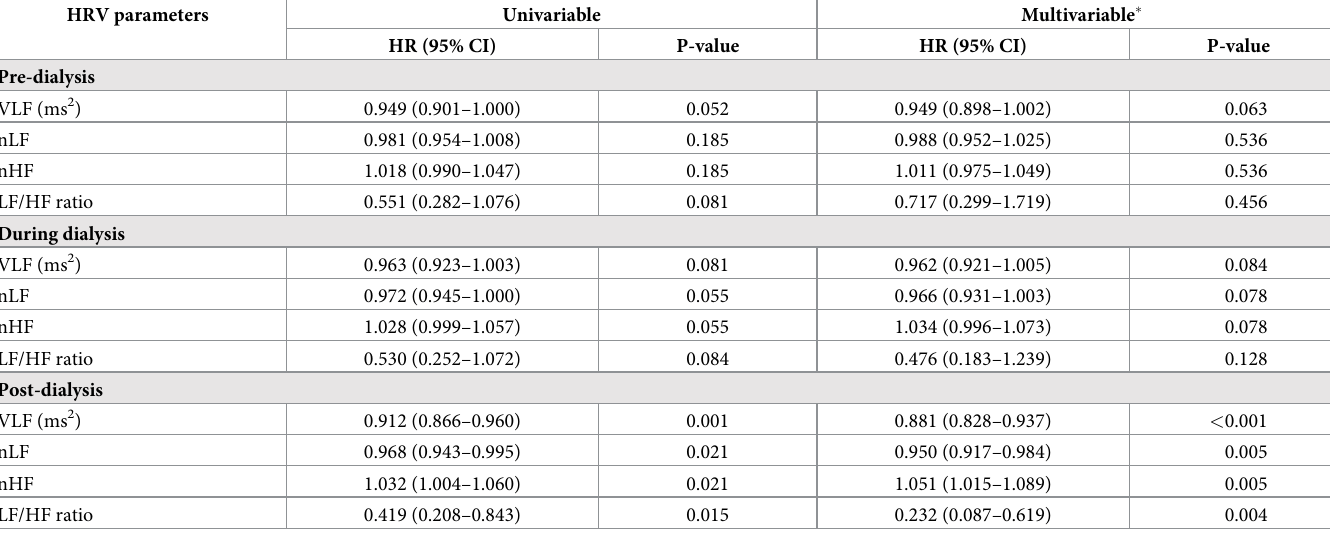
� Adjusted for age, LVEF, albumin, hemoglobin, coronary artery disease, use of beta-blockers, use of ACEI/ARB, use of oral anticoagulation, and pre-dialysis DBP. ACEI/ARB, angiotensin-converting enzyme inhibitor/angiotensin receptor blocker; DBP, diastolic blood pressure; LF/HF ratio, low frequency/high-frequency ratio; LVEF, left ventricular ejection fraction; nHF, normalized high frequency; nLF, normalized low frequency; VLF, very low